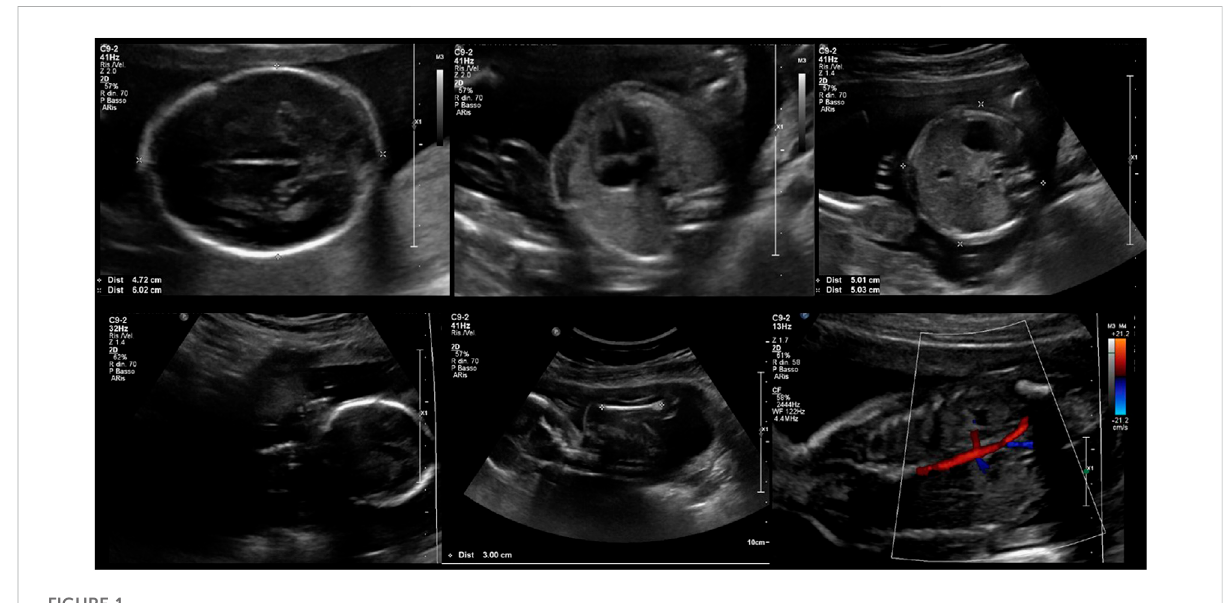
FIGURE 1 Fetal ultrasound assessment at 20 + 4 weeks of